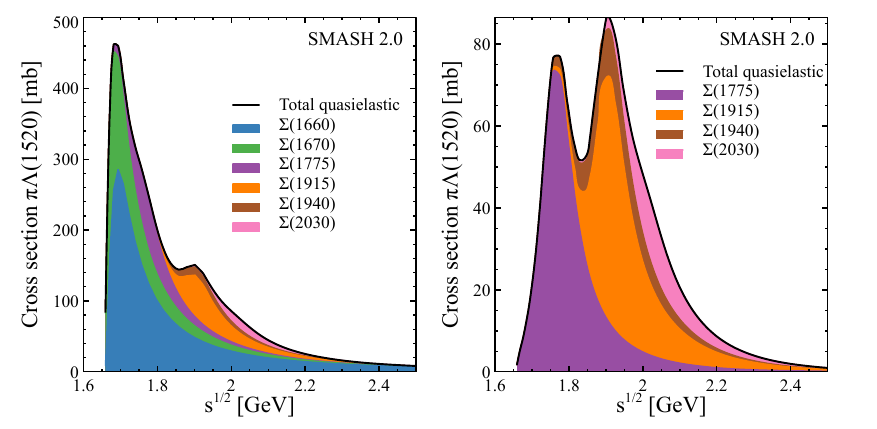
Σ ∗ in SMASH 2.0 . Left panel: Σ (1660) and Σ (1670) included; →